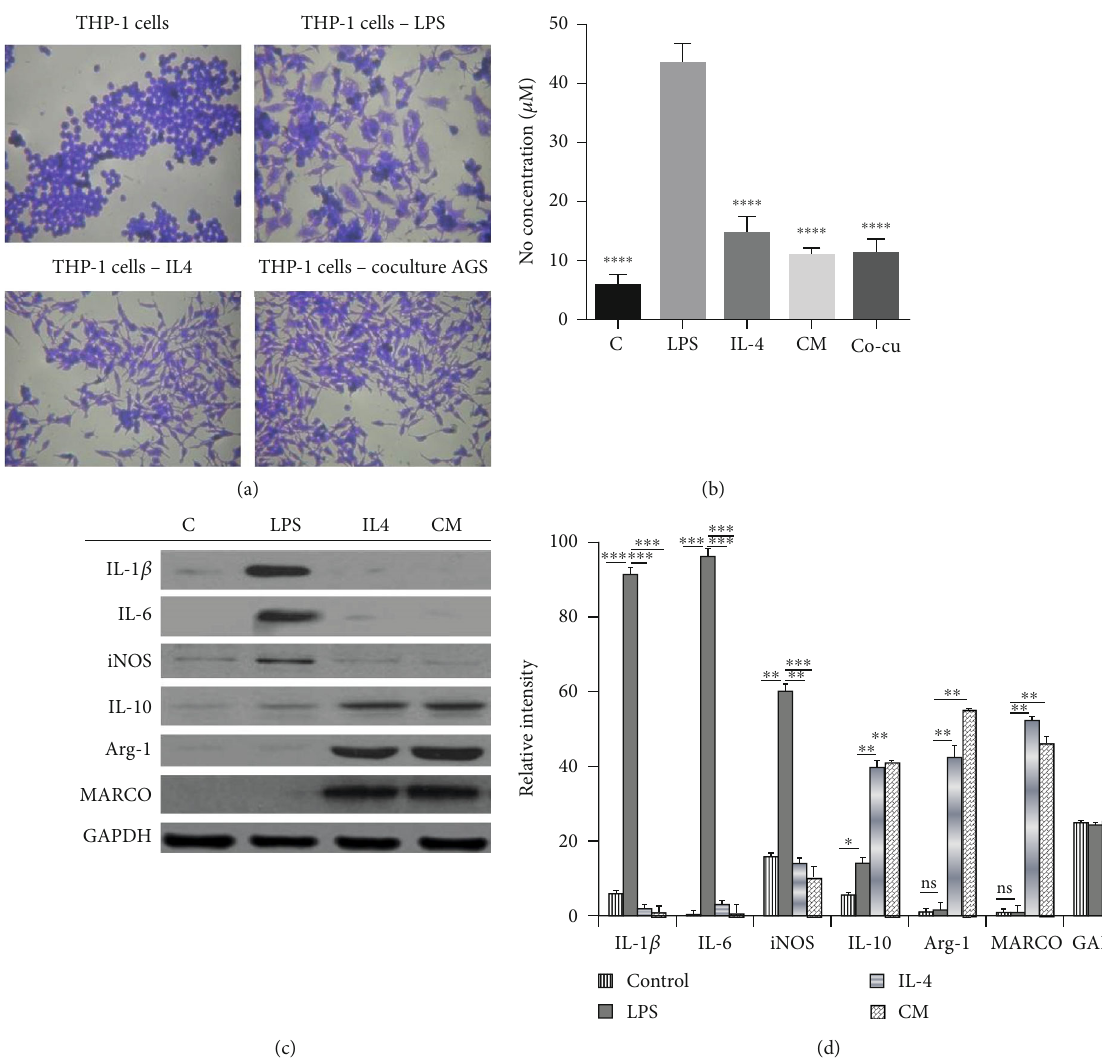
Figure 1: Polarization of THP-1 cells into M1 and M2 macrophages with LPS, IL-4, conditioned media, and coculture. (a) Crystal violet staining of polarized THP-1 cells. (b) DAPI and F-actin staining of polarized THP-1 cells. (b) NO assay of polarized THP-1 cells. (c) Western blot analysis of polarized THP-1 cells. In these experiments, THP-1 cells were plated in 24-well plates and 24-well plate inserts of 0.4 μ m pore size. The plates were incubated for 24h at 37 ° C. After 24h of incubation, THP-1 cells were stimulated with LPS (1 μ g/ml), IL- 4 (40 ng/ml), and conditioned medium (CM) from AGS cells, and fi nally, inserts containing THP-1 cells were added to well containing AGS cells, and the plates were incubated for further 24 h and further analyses were conducted. (d) Quanti fi cation of western blot bands. Statistically signi fi cant di ff erence was set at ∗ P < 0 : 05 , ∗∗ P < 0 : 01 , ∗∗∗ P < 0 : 001 , and ∗∗∗ ∗ P < 0 : 0001